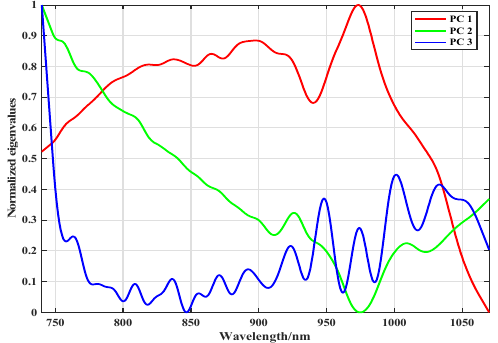
Figure 4. FD ‐ PCA Eigenvectors for the coffee samples.